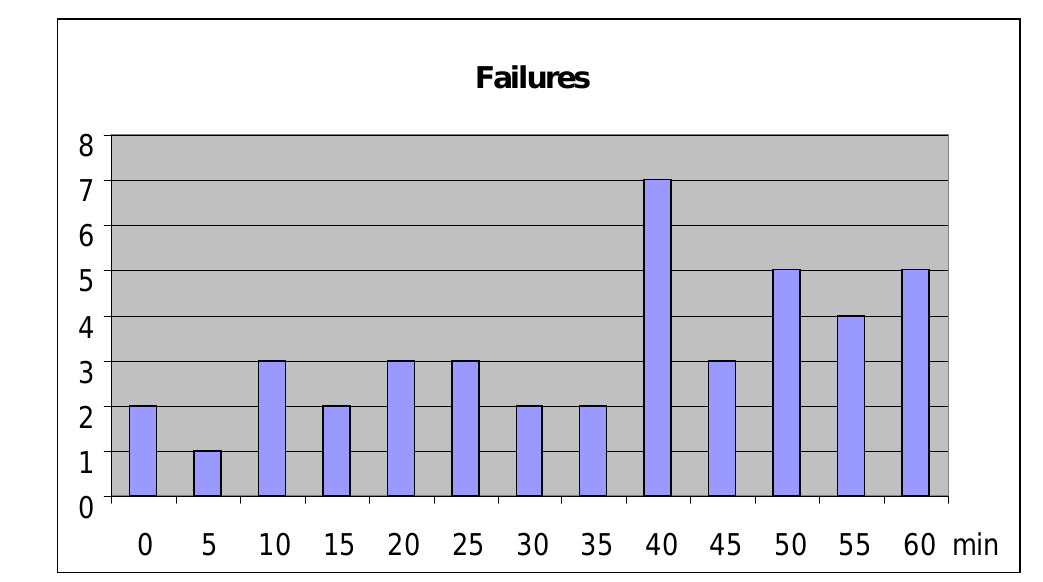
Figure 10. HCI errors in relation to